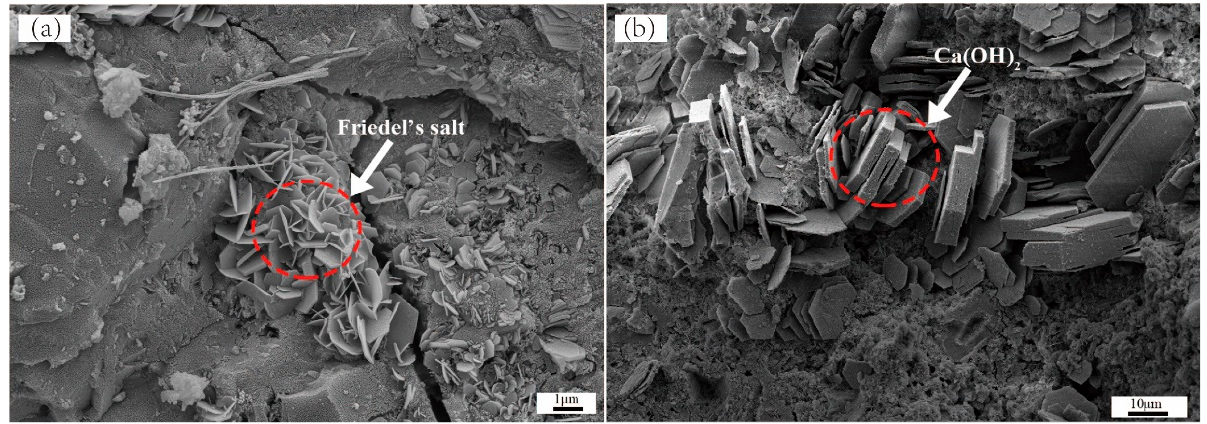
Figure 3. SEM image of hardened paste of ASR-10 cementitious material, the morphology of Friedel’s salt ( a ); and Ca(OH) 2 ( b ).